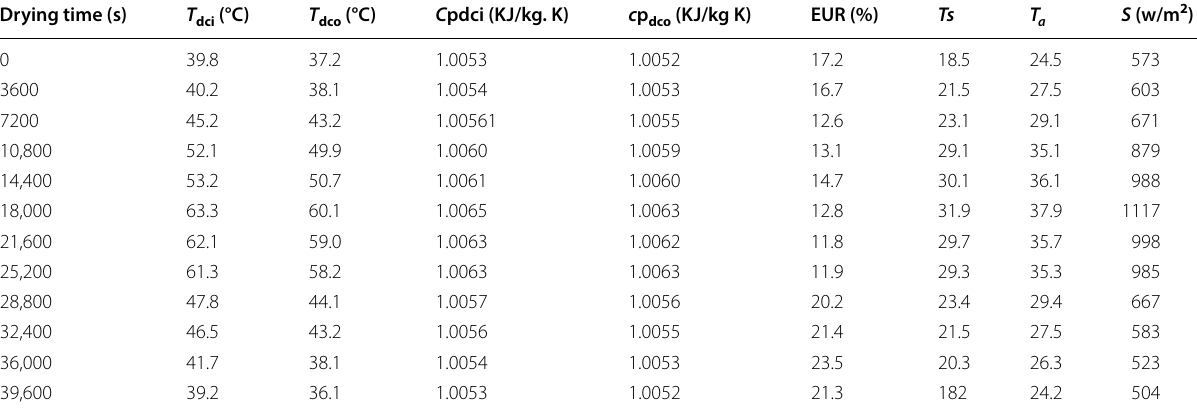
Table 21 Result energy analysis onion 3rd day